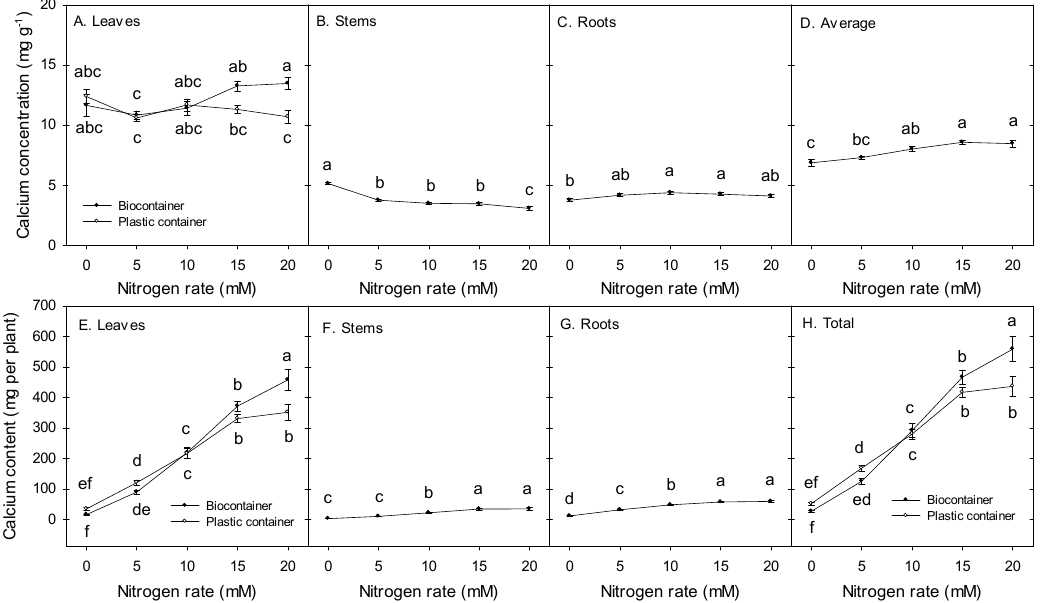
Figure 2. Concentrations (mg g − 1 ) and contents (mg per plant) of Calcium (Ca) in leaves, stems, roots, or the entire plant of H. macrophylla ‘Merritt’s Supreme’ a ff ected by the interaction between nitrogen or the entire plant of H. macrophylla ‘Merritt’s Supreme’ affected by the interaction between nitrogen (N) rate and container type ( A , E , H ) or by the main e ff ect of N rate ( B – D , F , G ). Data points are means (N) rate and container type ( A , E , and H ) or by the main effect of N rate ( B – D , F , and G ). Data points ( A , E , H ) across irrigation frequencies ( n = 10) and ( B – D , F , G ) across container types and irrigation are means ( A , E , and H ) across irrigation frequencies (n = 10) and ( B – D , F , and G ) across container frequencies ( n = 20). Error bars are standard errors. Di ff erent lower-case letters within a chart indicate types and irrigation frequencies (n = 20). Error bars are standard errors. Different lower-case letters significance di ff erences between means using Tukey’s HSD test at p -value ≤ within a chart indicate significance differences between means using Tukey’s HSD test at p -value ≤ 0.05.